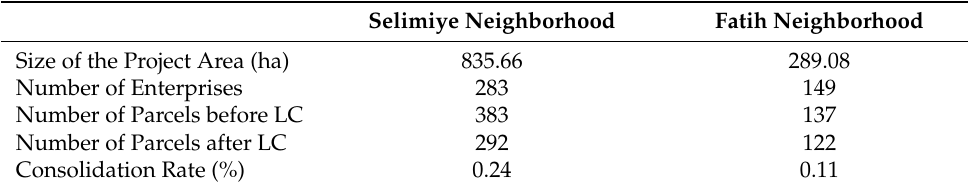
Figure 1. Map of the study areas. Table 1. Information on the study area.